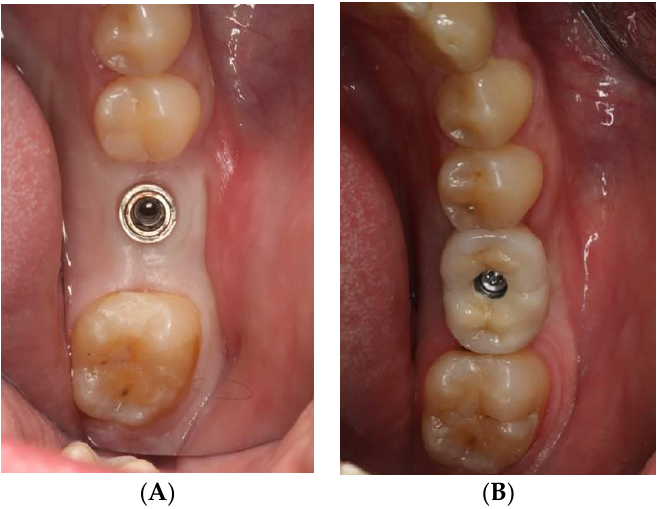
Figure 6. ( A ) implant bone level KOHNO in position 4.6, ( B ) implant tissue level KOHNO restored with a screw-retained single crown.